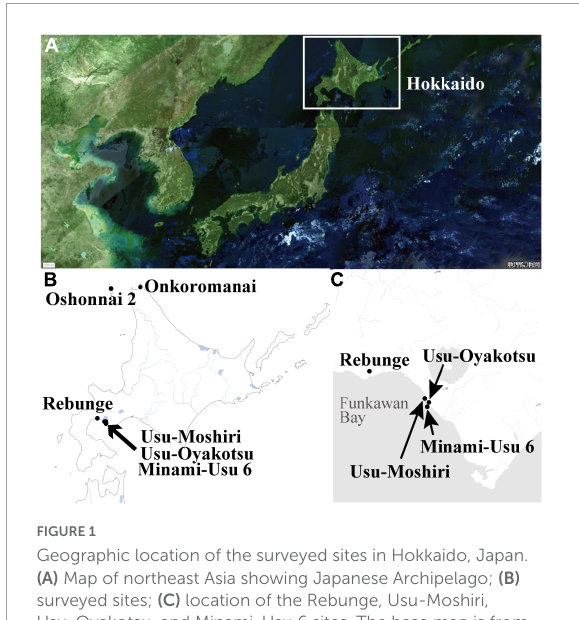
FIGURE1 Geographic location of the surveyed sites in Hokkaido, Japan. (A) Map of northeast Asia showing Japanese Archipelago; (B) surveyed sites; (C) location of the Rebunge, Usu-Moshiri, Usu-Oyakotsu, and Minami-Usu 6 sites. The base map is from the Geospatial Information Authority of